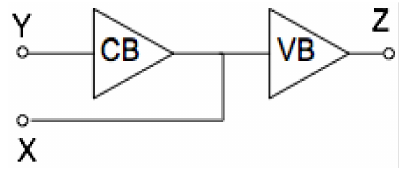
Figure 1. Internal structure of VCII.